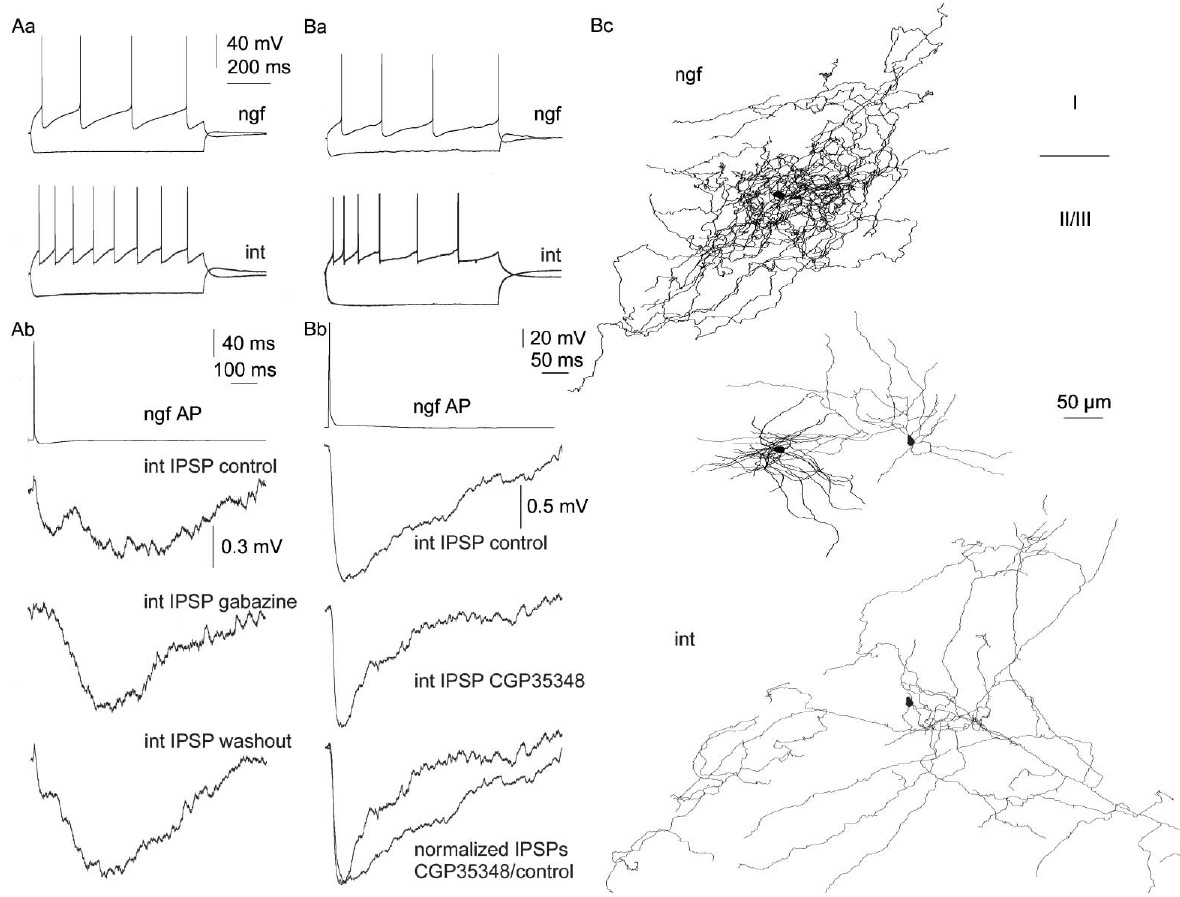
Figure 1. The effect of human neurogliaform cells is mediated by GABAA and GABAB receptors on postsynaptic interneurons . ( Aa ) Firing pattern of a human neurogliaform cell (ngf) and a postsynaptic interneuron (int). ( Ab ) Single action potentials of the neurogliaform cell elicited biphasic IPSPs in the interneuron in control conditions (top). The initial component of the IPSP was reversibly blocked by the GABAA receptor antagonist gabazine (10 µ M, middle and bottom). ( Ba ) Firing properties of a presynaptic neurogliaform cell (ngf) and postsynaptic interneuron (int) recorded in human association cortex. ( Bb ) The postsynaptic cell responded with a long-lasting IPSP to single action potentials evoked in the neurogliaform cell (top). The decay of IPSP could be shortened by the GABAB receptor blocker CGP35348 (60 µ M, middle and bottom). ( Bc ) Three-dimensional light microscopic reconstructions of the presynaptic neurogliaform cell (black) and the postsynaptic interneuron (gray). Axonal (top and bottom) and dendritic (middle) reconstructions are separated for clarity, the relative position of the two cells is shown by the dendritic arborizations.